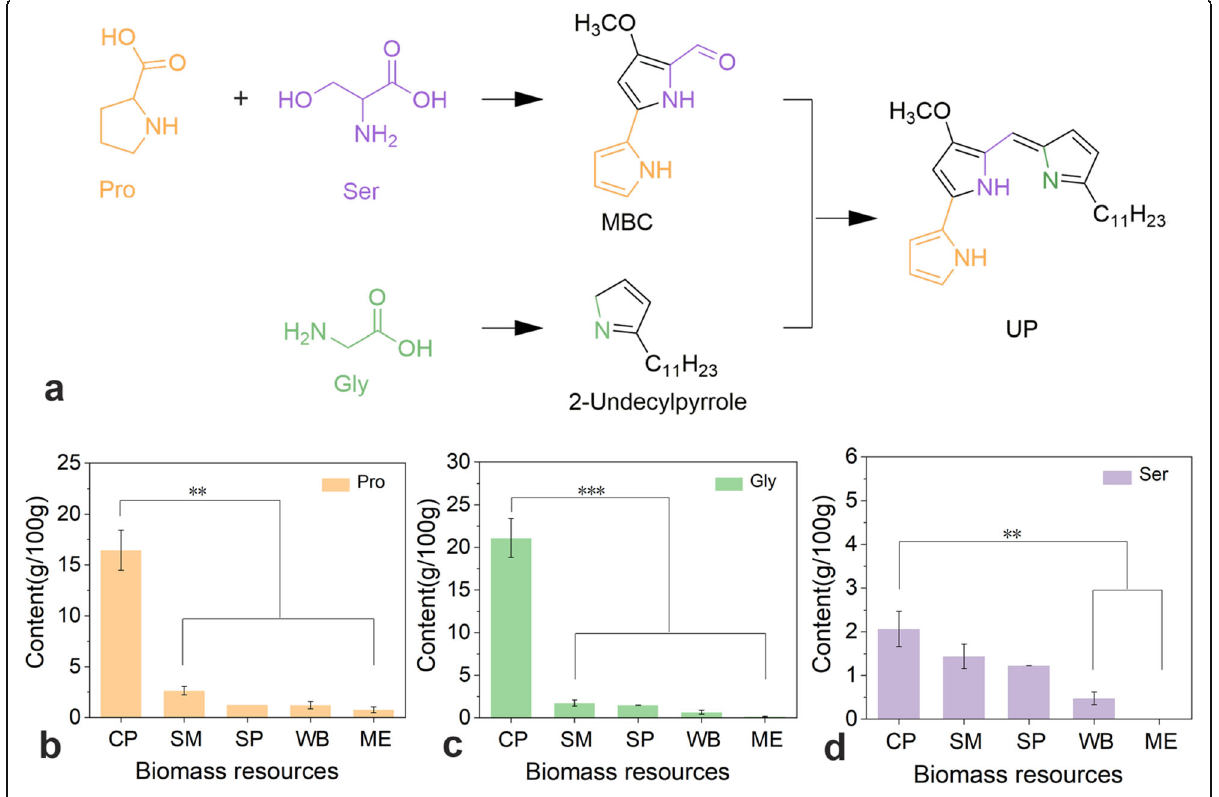
Fig. 3 UP precursor AAs, and their contents in CP and common plant biomass. a The structures of UP, precursor AAs and intermediates. Each color shows a different initial precursor amino acid. b - d The contents of Pro, Gly, and Ser in the biomass resources of CP, soybean meal (SM), soybean powder (SP), wheat bran (WB) and malt extract (ME), respectively. MBC: 4-methoxy-2,2 ′ -bipyrrole-5- carbaldehyde. P values represent levels of significant ( p <0.001 ***, p <0.01 **, p <0.05